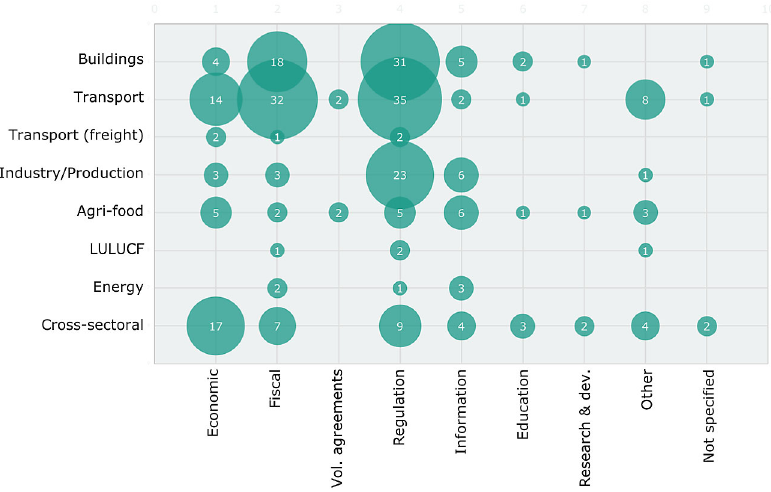
Figure 4. Number of policy instruments by sector and instrument type. Note: Bubble sizes indicate the number of